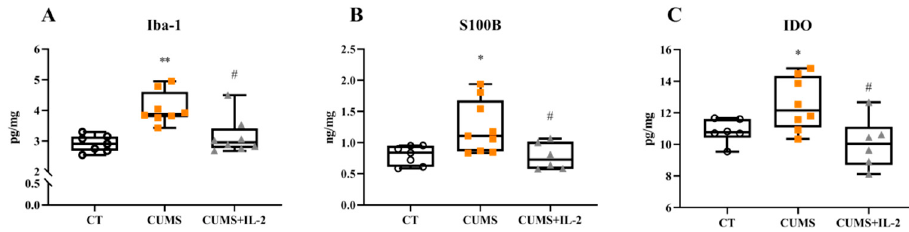
Figure 5. IL-2 restored the mRNA and protein expression of Th17 and Treg cell transcription fac-